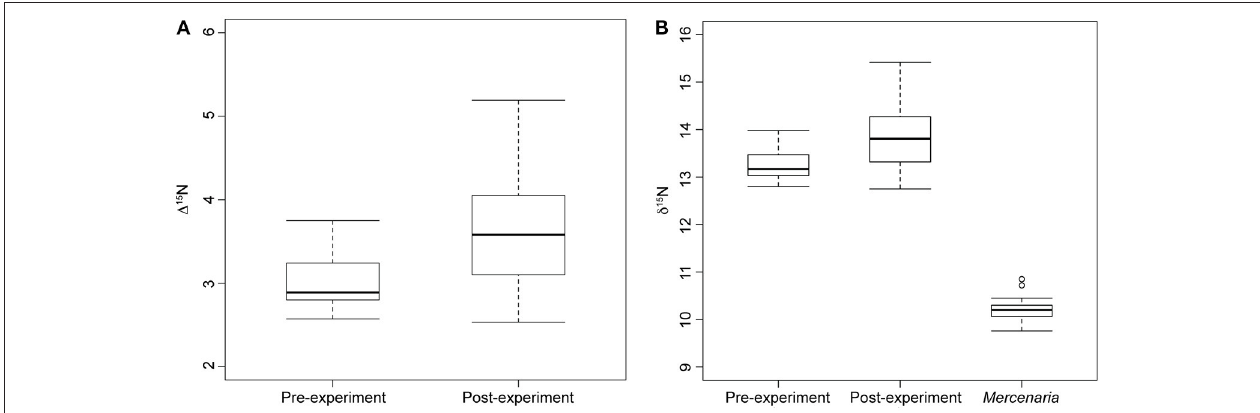
FIGURE 2 | Box plots showing median, standard deviation, minimum, and maximum nitrogen discrimination factors and nitrogen signatures. (A) Median nitrogen discrimination factor of moon snails sacrificed before the start of the experiment (Pre-experiment) and moon snails sacrificed after the year-long experiment (Post-experiment). Discrimination factor calculated as nitrogen signature of moon snails minus average M. mercenaria nitrogen signature. (B) Nitrogen signatures of experimental M. mercenaria including two outliers, pre-experiment moon snails, and post-experiment moon